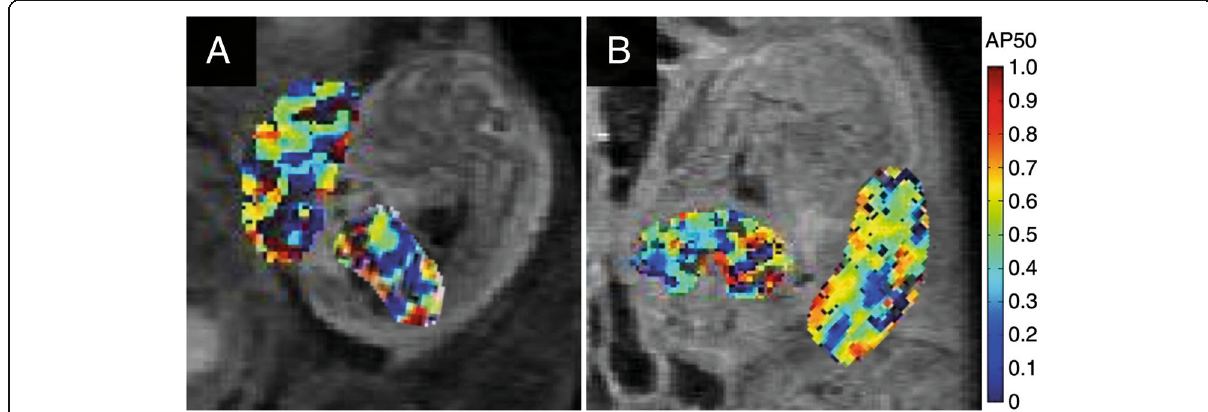
Fig. 6 BOLD imaging analysis of pregnant mice. Representative spatial distribution maps of the oxygen-haemoglobin dissociation inside the placenta and foetal liver on days 14.5 ( a ) and 17.5 ( b ) show distribution and variability